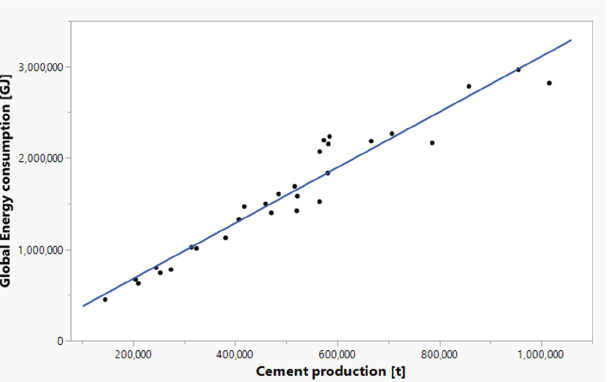
Figure 16. NACE 23.51 linear regression of site thermal consumption.